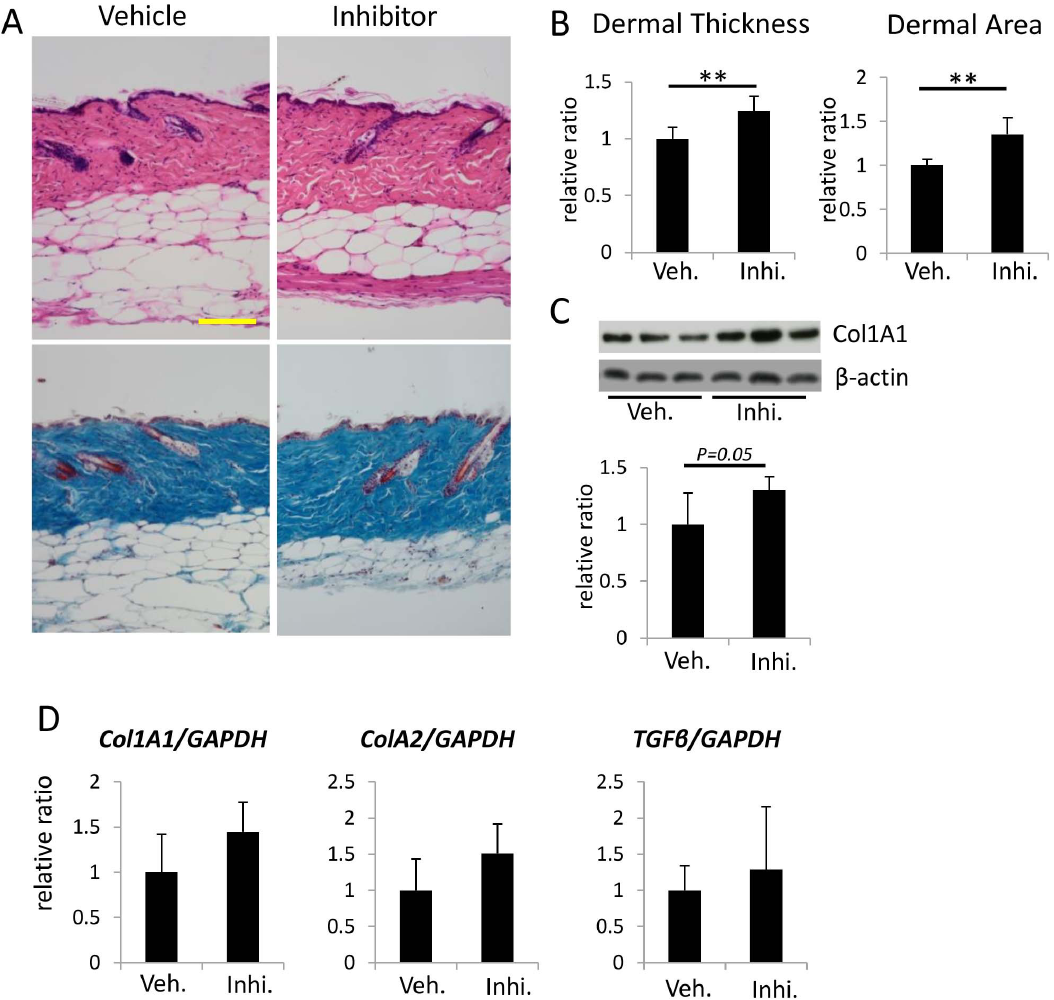
Figure 3. Effects of 11 b -HSD1 inhibition on dermal thickness and expression of a collagen-associated gene in 1-year-old C57BL/6 mice. (A) Representative H&E and Masson’s trichrome staining of 11 b -HSD1 inhibitor-treated and vehicle-treated mouse skin (N=6 per group). Bar =100 m m. (B) Dermal thickness and the dermal area of 11 b -HSD1 inhibitor-treated and vehicle-treated mice. Dermal thickness was calculated by averaging the thickness measured at five locations in each section. Three sections from each mouse were evaluated. The dermal area in each mouse was measured using Image J. Bars show the mean epidermal thickness 6 SD (N=6; **P , 0.01, Student’s t-test). (C) Western blot analysis of Collagen type 1 expression in mouse skin from three individual animals treated with the 11 b -HSD1 inhibitor or vehicle. Bars show the results of densitometric analysis relative to b -actin. Mean 6 SD of each group are shown. (N=6) (D) The relative expression of Col1A1, Col1A2 and TGF b 1 in 11 b -HSD1 inhibitor-treated and vehicle-treated mouse skin was assessed with rtPCR. GAPDH was used as an internal control. Bars indicate the mean 6